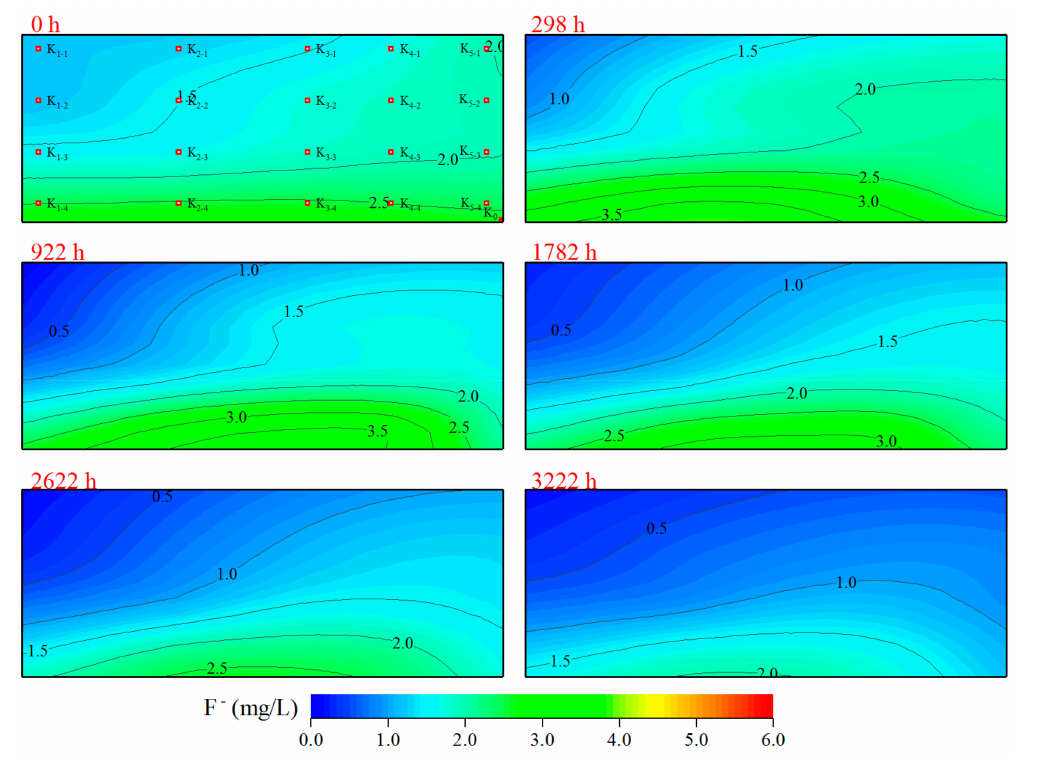
Figure 13. F − concentration of the soil solution in a soil tank experiment over di ff erent